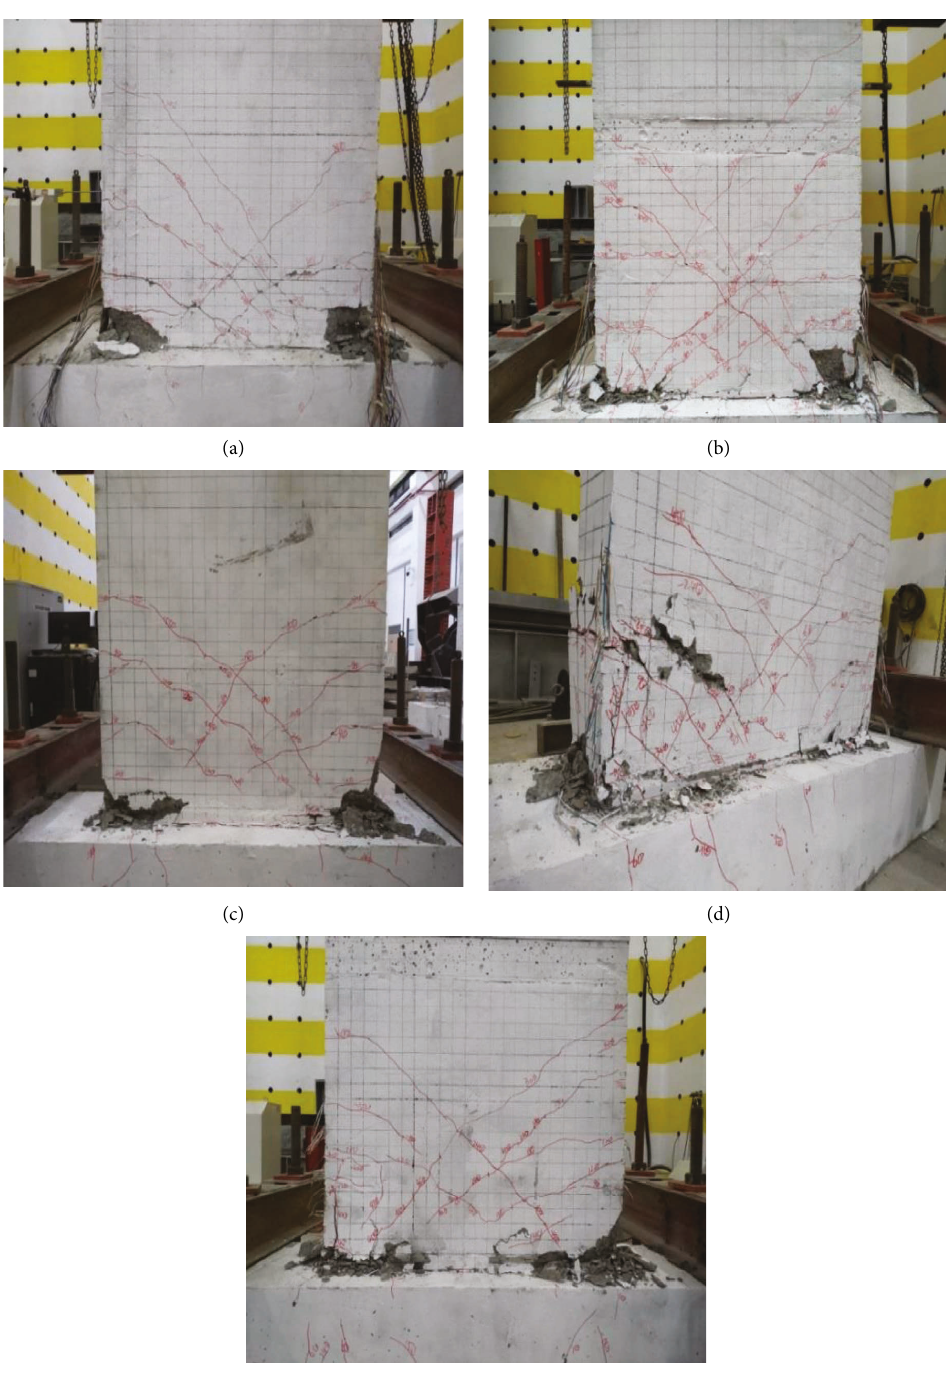
Figure 6: Failure mode and crack distribution. (a) XJ. (b) YZ1. (c) YZ2. (d) YZ3. (e)